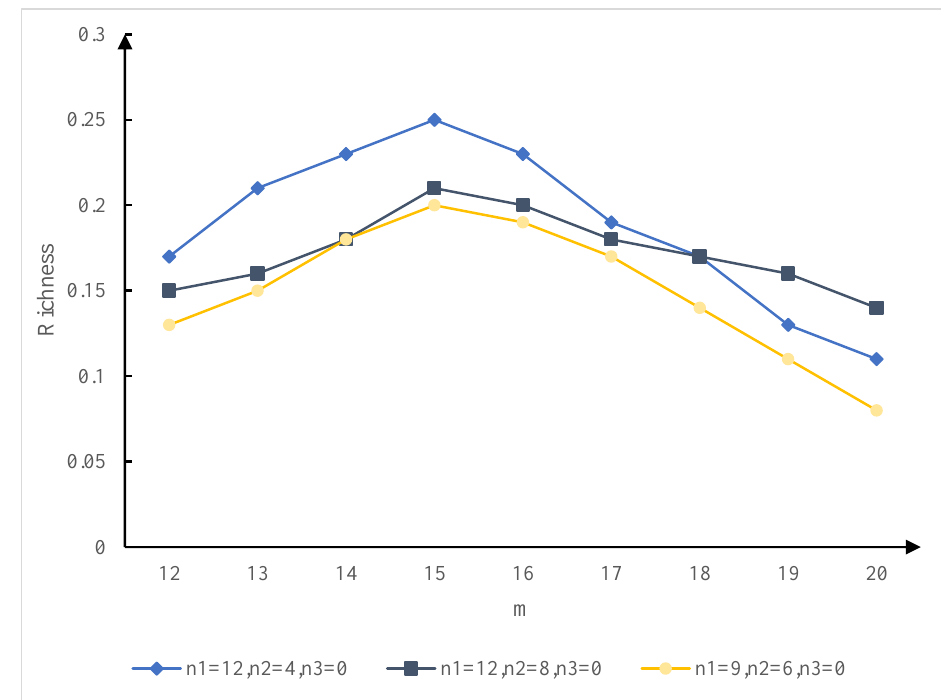
Figure 4. The influence of parameter m on richness under different parameters.